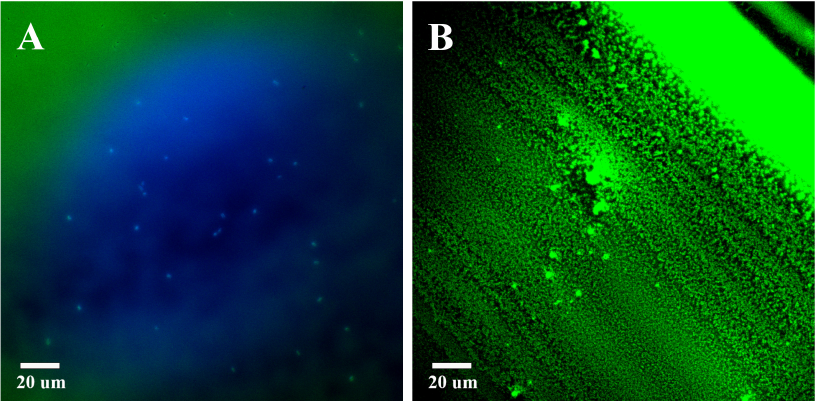
Figure 8. Confocal fluorescence images of ( A ) 1.0 mg/mL (with 405 nm and 488 nm laser co-excitation) and ( B ) 10.0 mg/mL (with 488 nm laser excitation) of PEI@CNDs solutions.